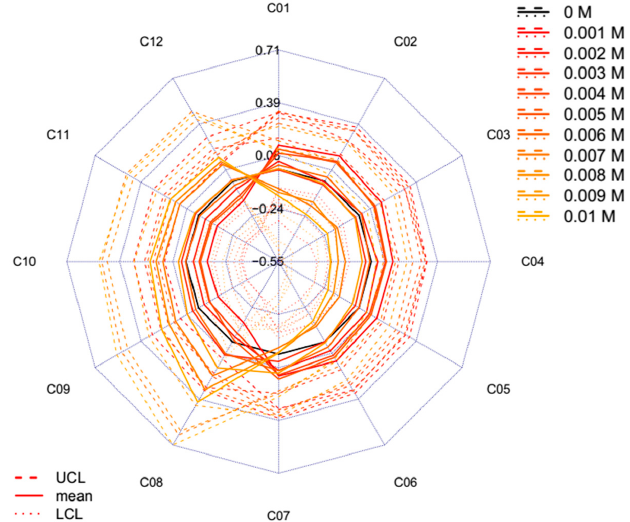
Figure 7. Aquagrams with 95% confidence intervals of Milli-Q water ( n = 150) and 0.001–0.01 M KCl solutions ( n = 60) calculated with the temperature based aquagram calculation method on the individual concentrations (UCL—upper confidence level, LCL—lower confidence level).